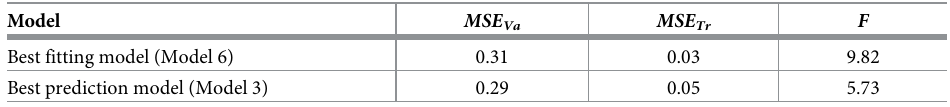
) and the training data set ( MSE Va